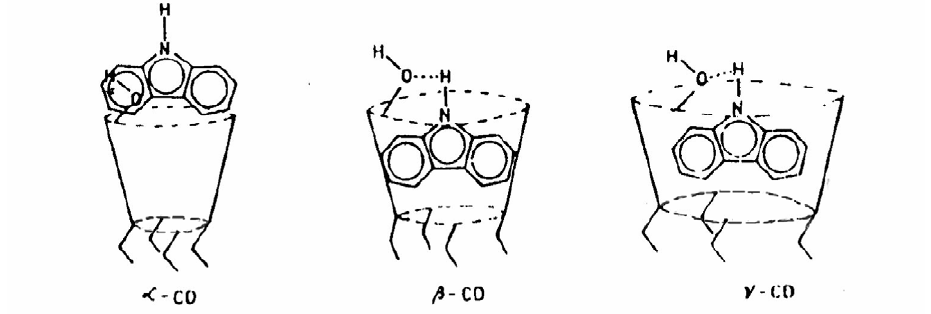
Figure 9. Schematic encapsulation of CAZL in different